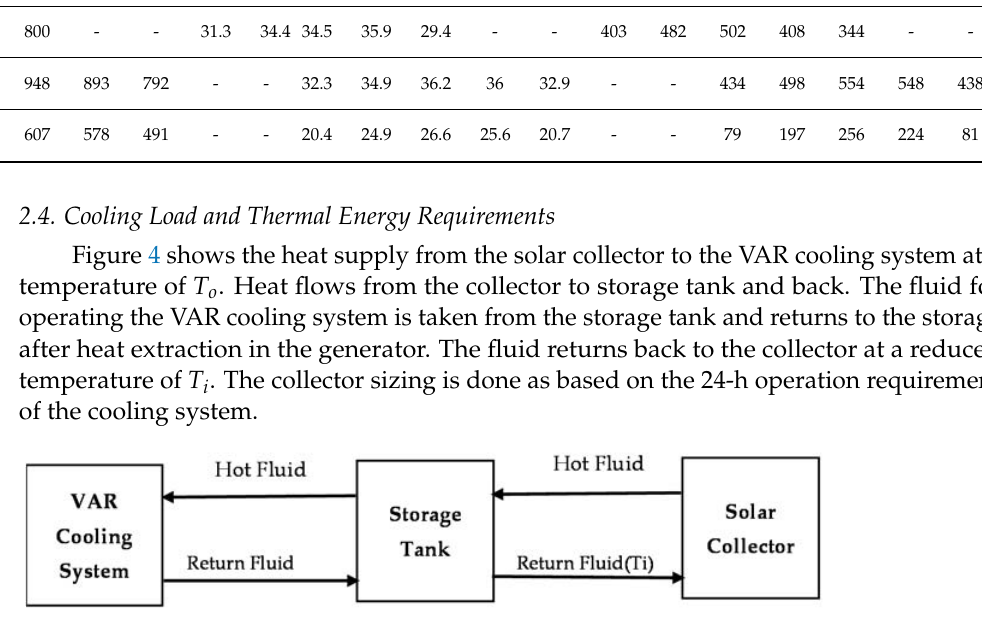
Figure 4. Heat supply between solar collector and VAR system.